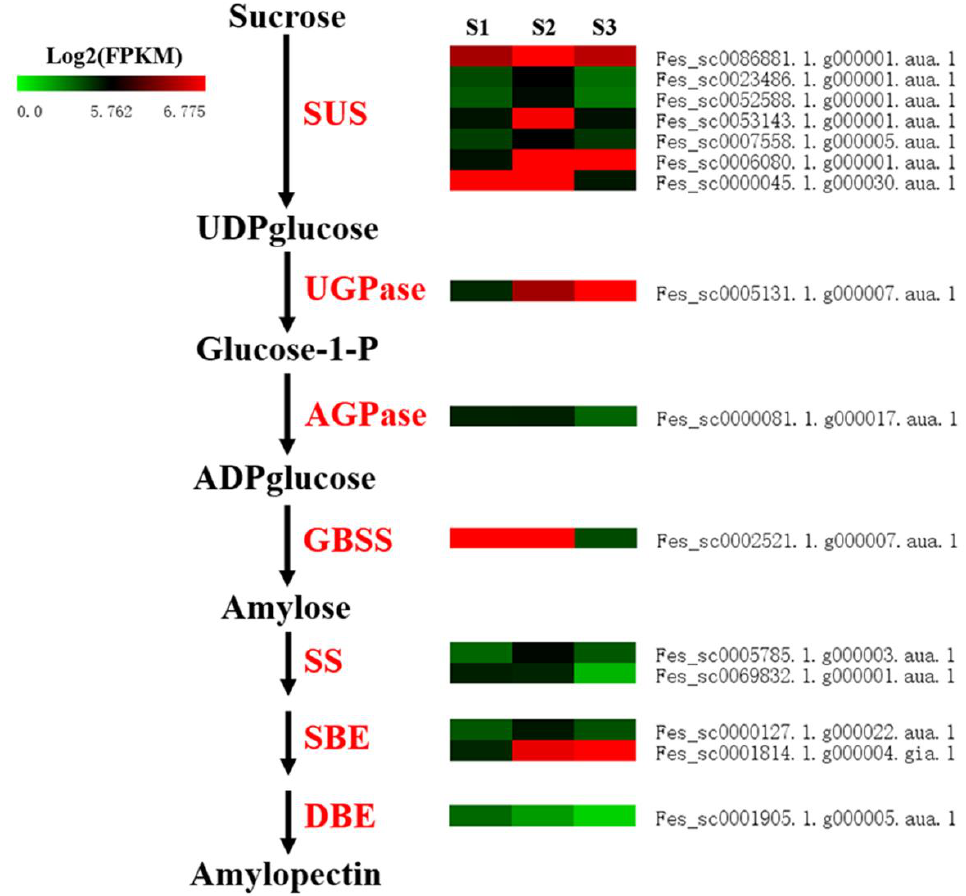
Figure 6. Expression patterns of starch biosynthesis genes that were differentially expressed during seed development. SUS : Sucrose synthase, UGPase : UDP glucose pyrophosphorylase, AGPase : ADP glucose pyrophosphorylase, GBSS : Granule bound starch synthase, SS : Starch synthase, SBE: Starch-branching enzyme ( SBE ), DBE: Debranching enzyme. S1, S2, and S3 stand for the seed samples at pre-filling stage, filling stage, and initial maturity stage, respectively.